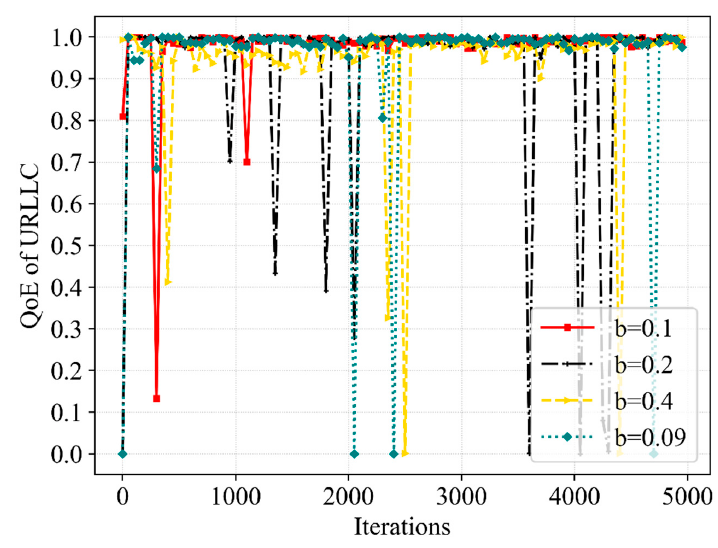
Figure 12. A comparative result of QoE for URLLC service at various b .